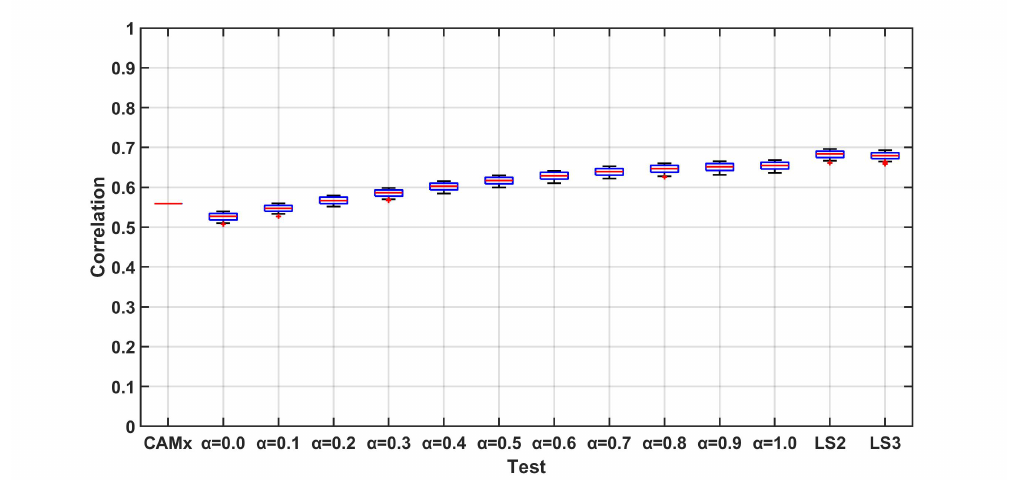
Figure 5. Correlation for the two-step-forward forecast.